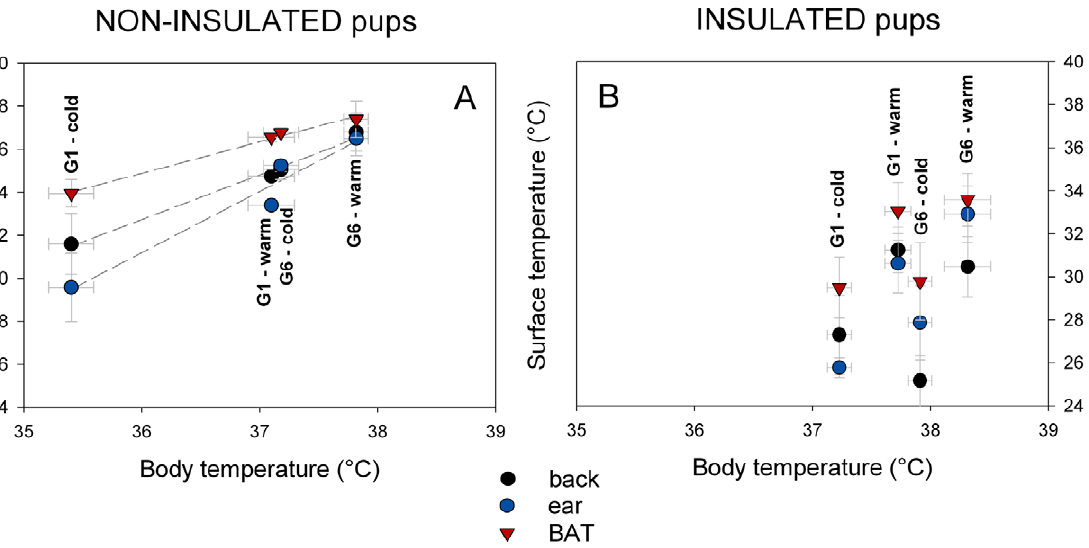
Figure 4. Surface temperature of back, ear and brown adipose tissue (BAT) of non-insulated (Figure 5A) and insulated (Figure 5B) pups (isolated, G1 or huddling, G6) as a function of their body temperature. Regression lines are statistically significant for non-insulated pups only. Non-insulated pups: T BAT = 2 17.79 + 1.46*T b , r 2 =0.992, p=0.004; T ear = 2 71.46 + 2.85*T b , r 2 =0.950, p=0.025; T back = 2 42.14 + 2.08*T b , r 2 =0.988, p=0.006. Insulated pups: T BAT , r 2 =0.436, p=0.340; T ear , r 2 =0.732, p=0.144; T back , r 2 =0.086, p=0.707.